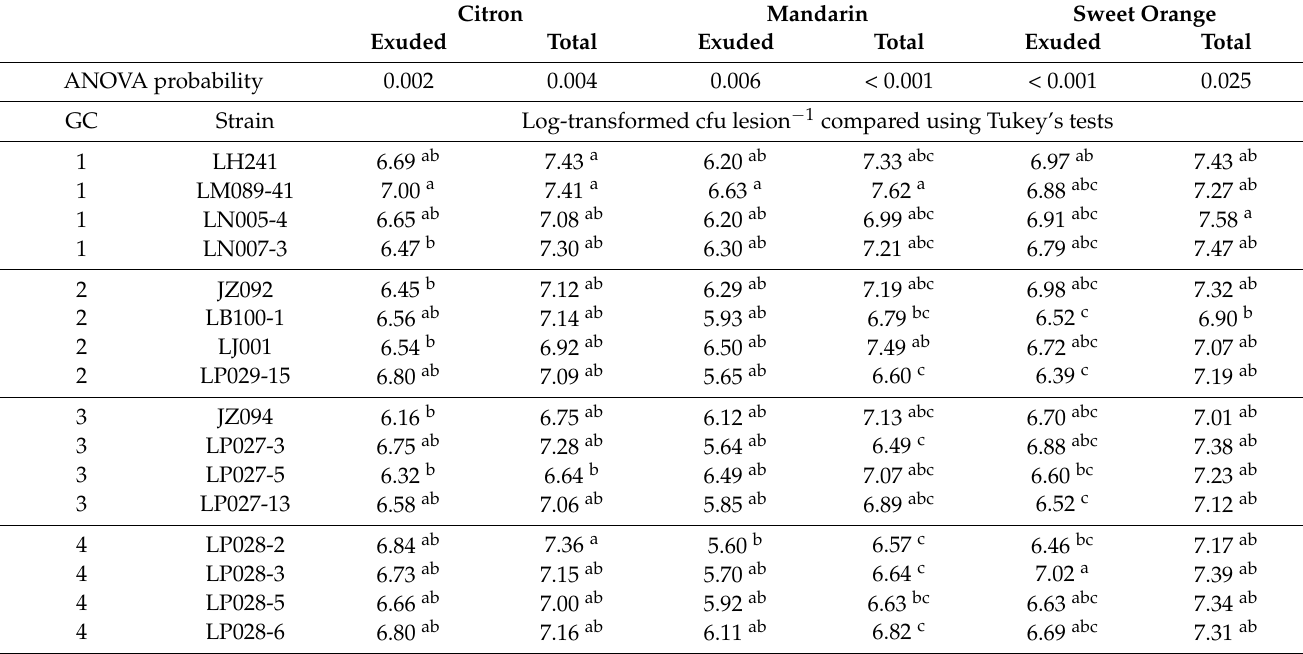
Table 3. Comparisons among strains of exuded or total Xanthomonas citri pv. citri population sizes enumerated from single canker lesions 25 days after spray inoculation of three host species. Citron Mandarin Sweet Orange Exuded Total Exuded Total Exuded